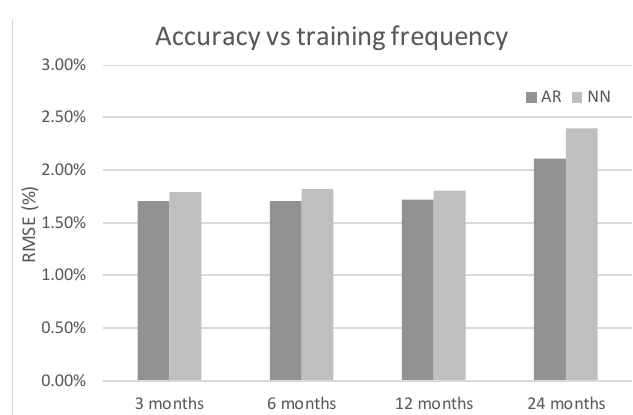
Figure 13. Forecasting error (RMSE) for AR and NN models with training frequency from 3 to 24 months.